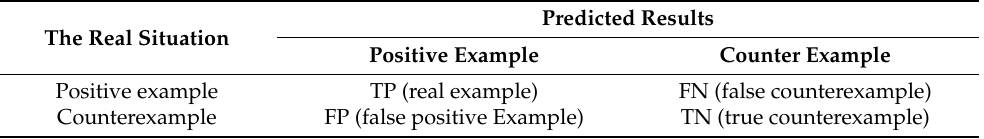
Table 1. Confusion matrix of classification